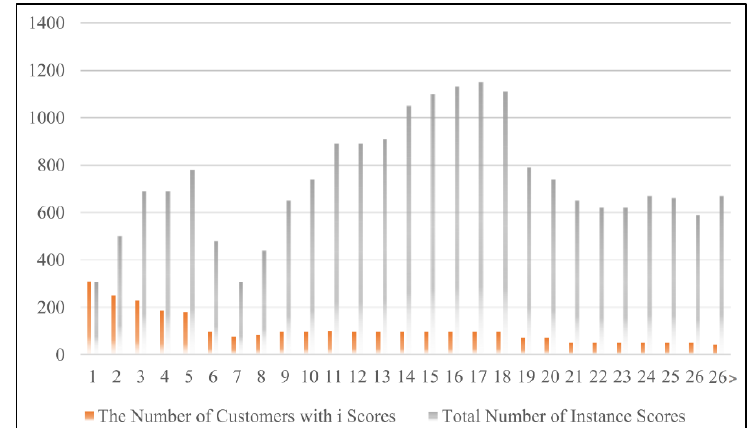
Figure 6. Score frequencies of Saman Bank club system.